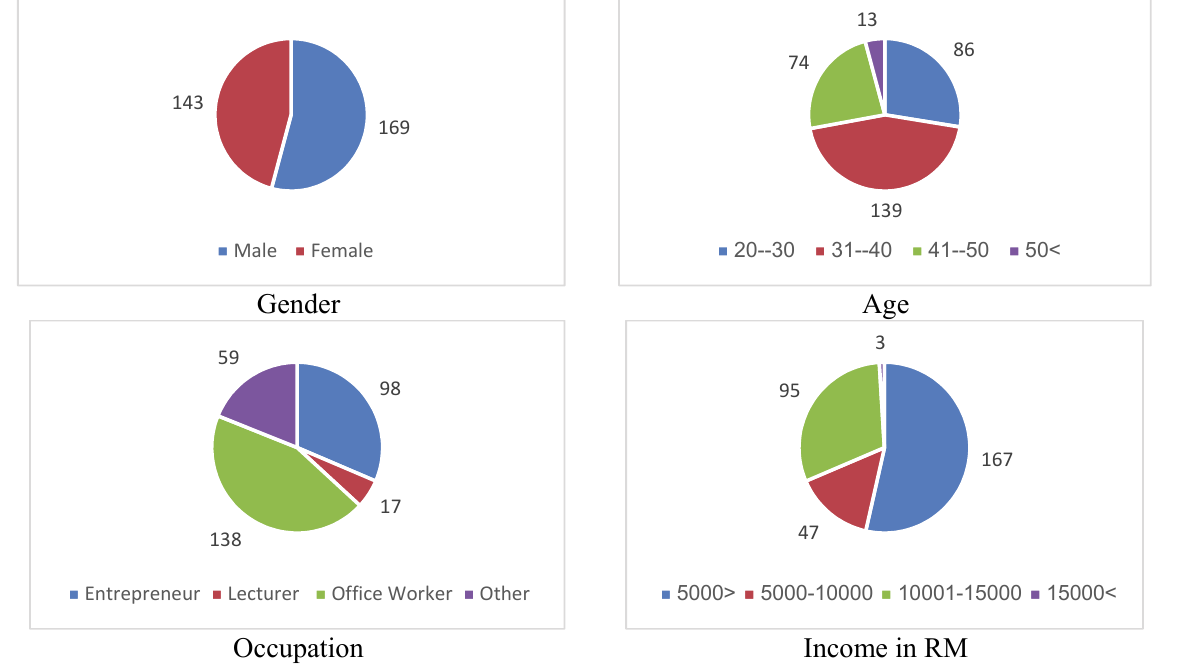
Fig. 2. Personal characteristics of the participants